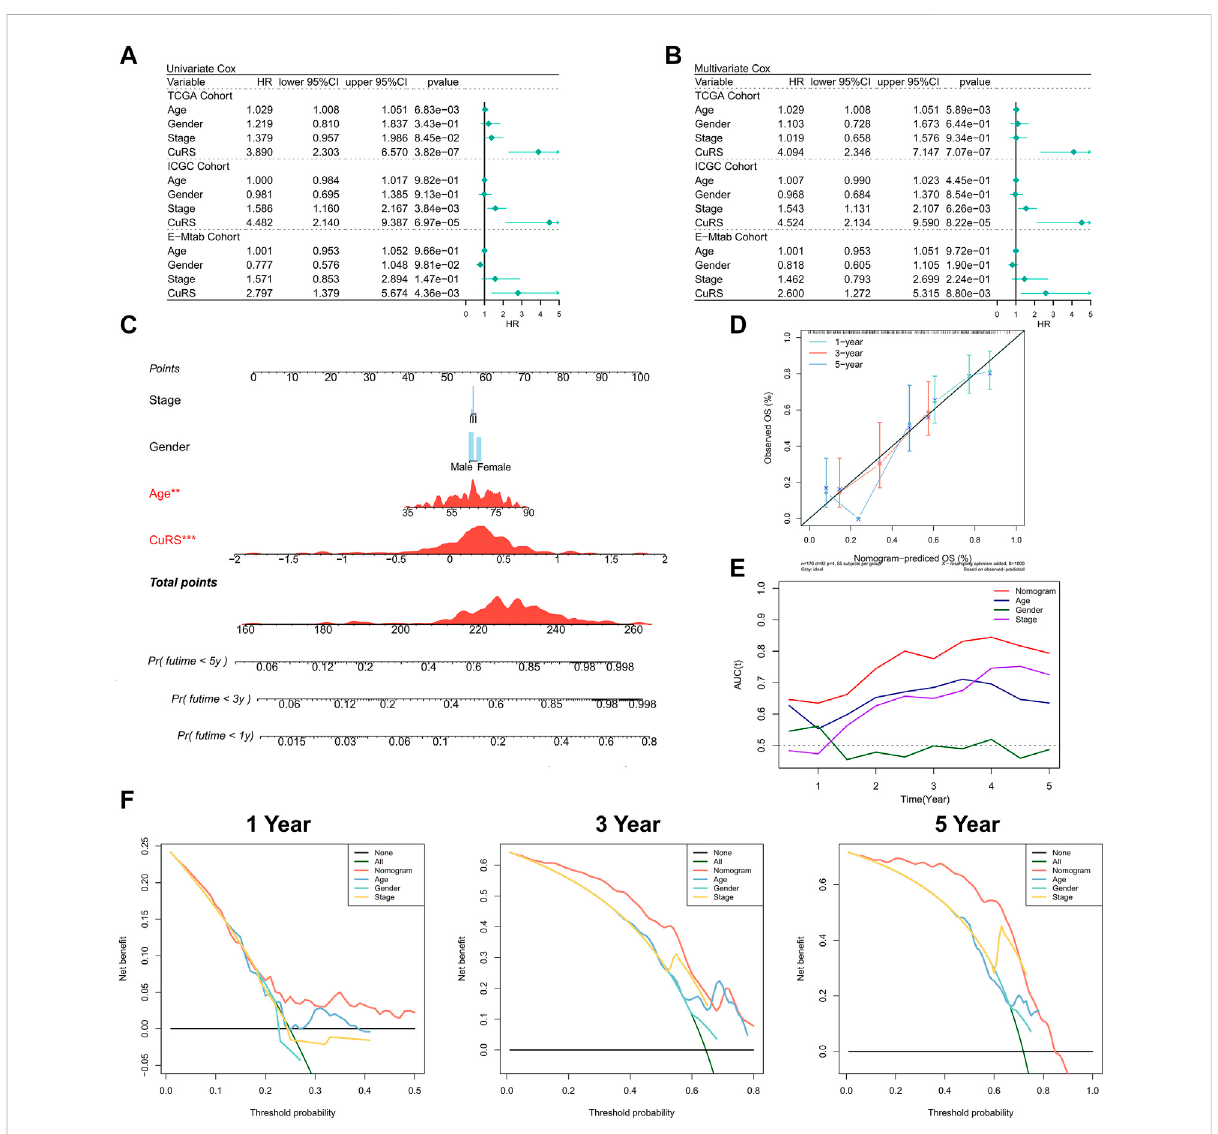
FIGURE 3 ValidationoftheCuRSmodel. (A) UnivariateCoxregressionanalysisofOSinTCGA,ICGC,andE-MTABdatasets; (B) multivariateCoxregression analysisofOSinTCGA,ICGC,andGEdatasets; (C) FRS-basednomogram; (D) Calibrationcurvesforthenomogram; (E) NomogramandtROCcurves for clinical characteristics; (F) 1-, 3-, and 5-year DCA curves for the